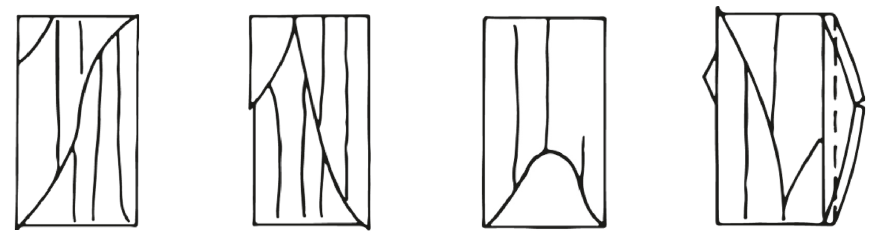
Figure 6: Fracture modes of rock specimens in uniaxial compression, from You and Hua